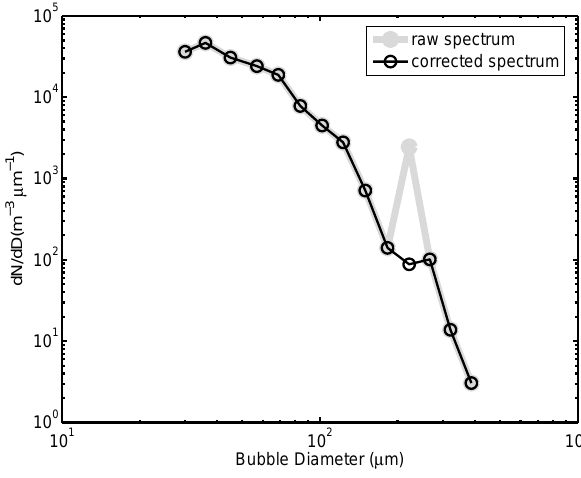
Fig. 5. An individual two-minute estimate of a bubble spectrum showing a pronounced spike resulting from multiple counting of a bubble stuck on the camera window (grey), and the corrected spec- trum